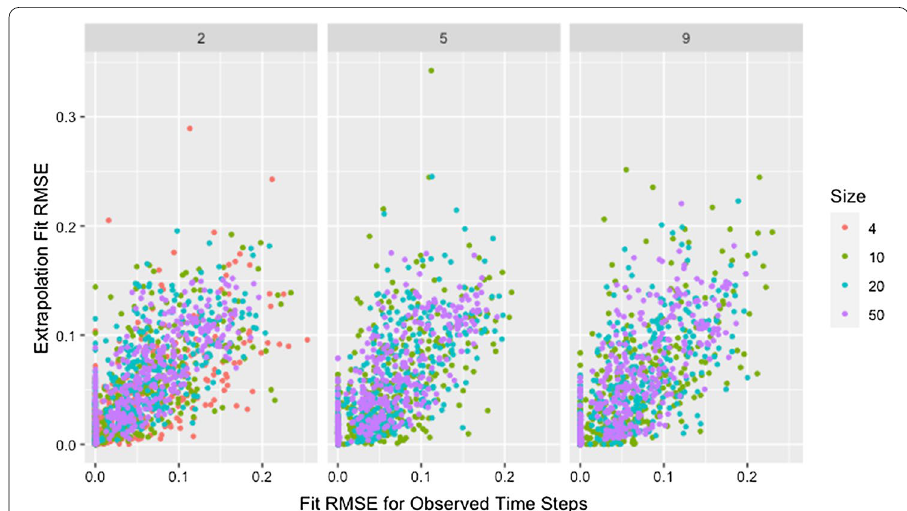
Fig. 15 Extrapolation RMSE by fit RMSE, size, and degree. RMSE for observed and predicted opinions on extrapolated time steps by RMSE for observed and predicted opinions on observed time steps, network size, and target degree across panels